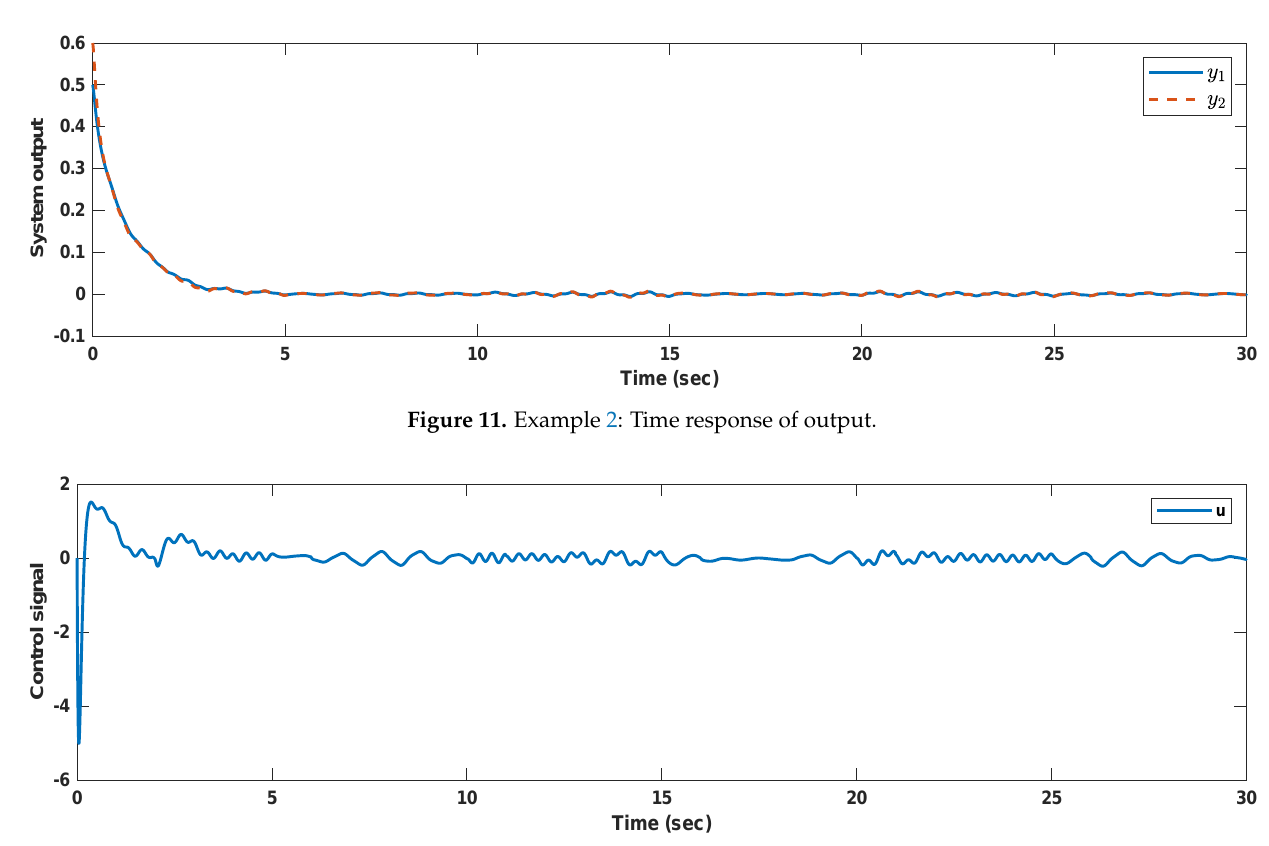
Figure 12. Example 2: Control